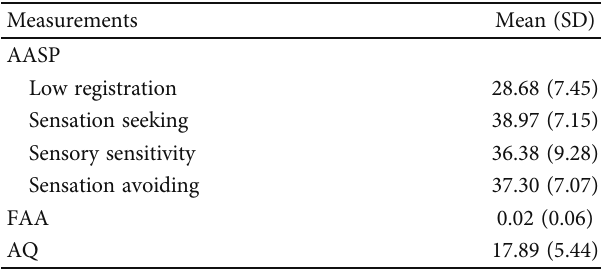
Table 1: Descriptive statistics of